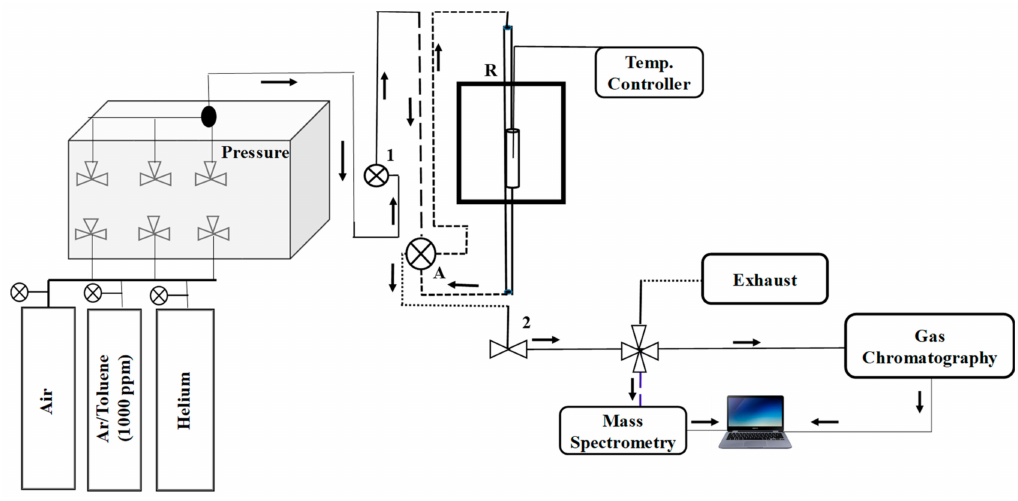
Figure 8. Schematic diagram of the experimental set-up used for abatement of toluene by adsorption / catalytic